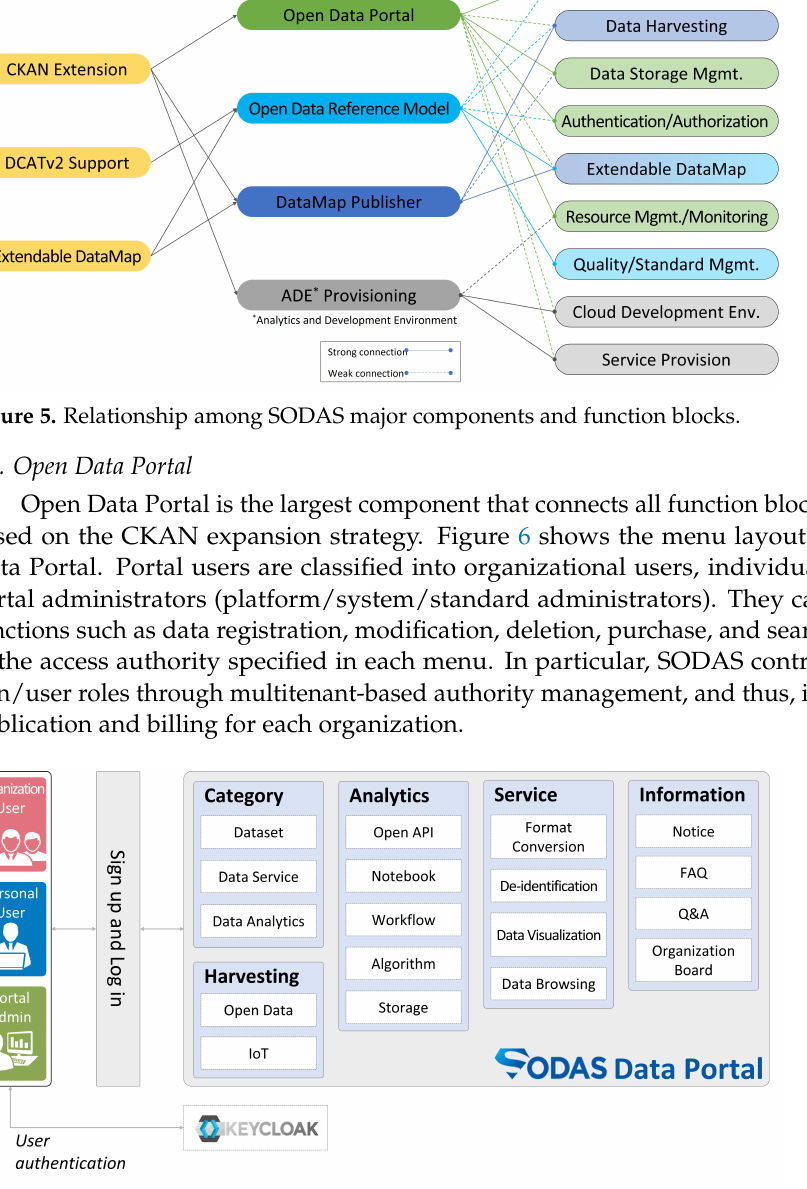
Figure 6. Menu layout of Open Data